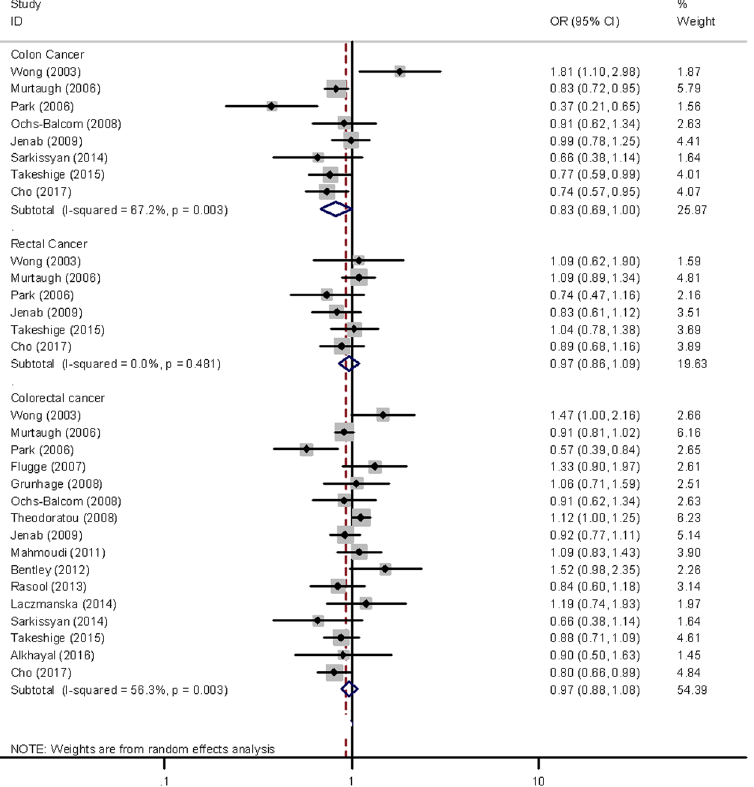
Figure 1. Forest plot showing the risk of colorectal cancer associated with VDR Fok I polymorphism (Ft vs. FF).